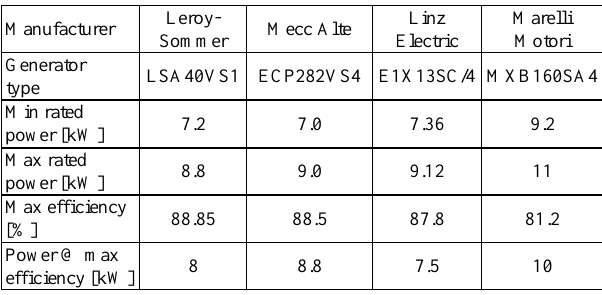
Table 2. Technical data of chosen synchronous generator Manufacturer